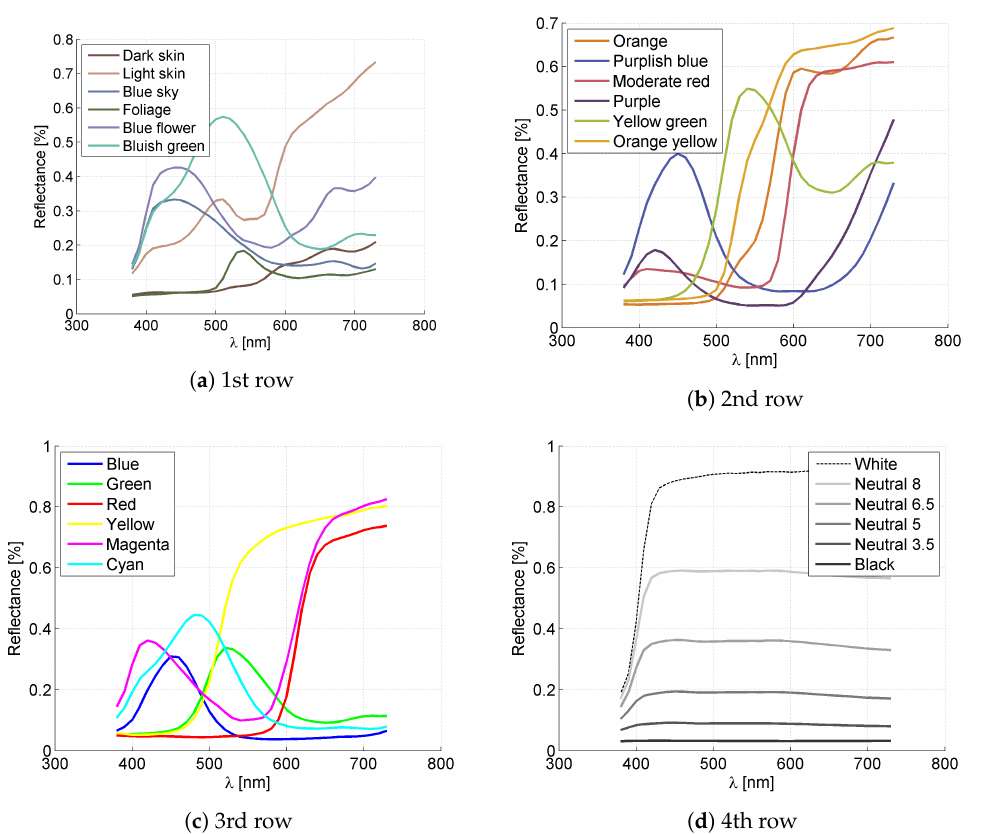
Figure 8. Spectral reflectance curves of the color patches in each row of the McBeth color